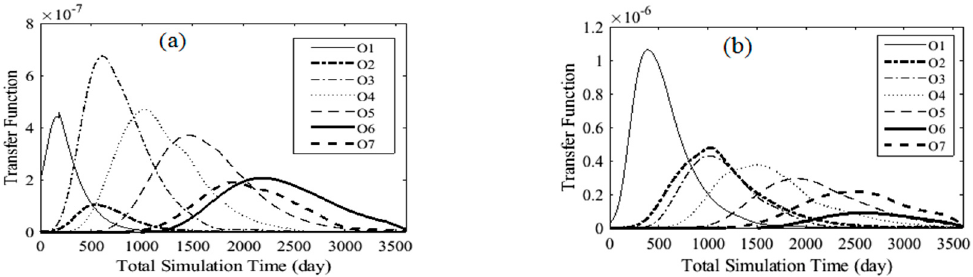
Figure 5. Transfer function curves in sampling wells due to source 1 ( a ) and source 2 ( b ); they represent g ( x , t ) of Equation (5).